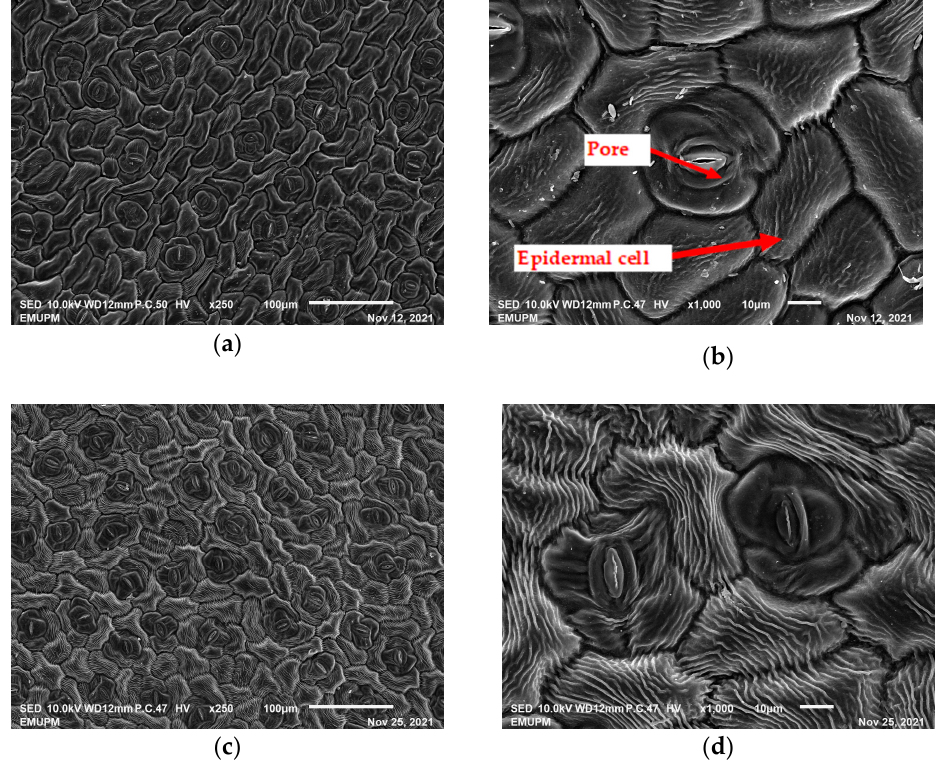
Figure 3. SEM micrographs showing surface structure of control pennywort leaves on the surface overview ( a ) and close up ( b ) on day 0, overview of the surface ( c ) and close up of a leaf ( d ) on day 12. After storage, there is a degradation of the leaf structures, as evidenced by stomata that have sunk and cellular morphology with decreased turgor, as shown in Table 1.